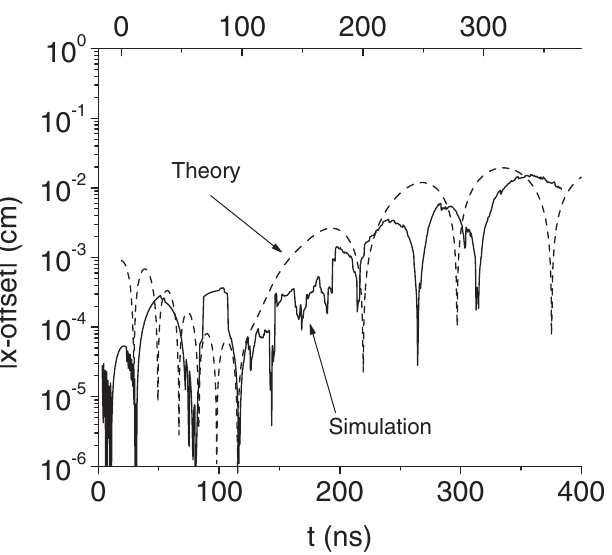
FIG. 11. Same as Fig. 10 except for a